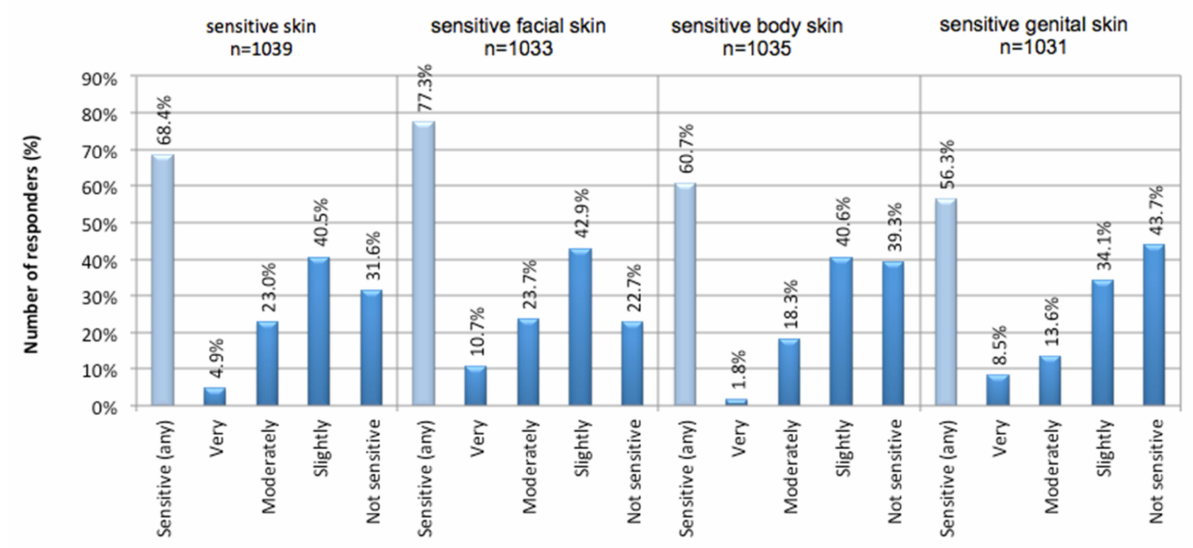
Figure 1. Prevalence of SSS. In a study conducted in the Cincinnati area among 1039 subjects, participants were asked to describe their skin and given possible responses of: not sensitive, slightly, moderately, or very sensitive. Participants were subsequently asked to use the same four-point scale to rate their skin in the following areas: facial area, body area, and genital area. The percentage of participants giving each response is plotted (adapted from